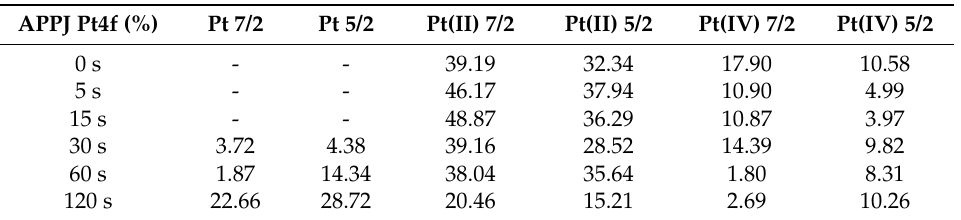
Table 1. Percentage of Pt species obtained from XPS analysis.